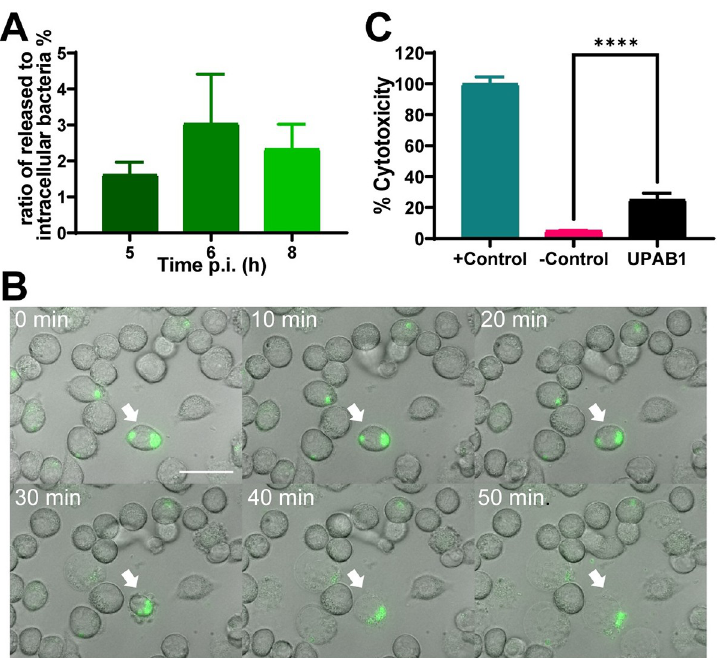
Fig 5. UPAB1 escapes the macrophages by a lytic process. J774A.1 macrophages were infected with UPAB1. (A) At different time points, antibiotic containing medium was replaced by antibiotic-free medium. CFU in supernatants were determined and the ratio of released to intracellular bacteria was calculated. Data represent mean and standard deviation values for 3 independent experiments. (B) Images from time-lapse microscopy showing UPAB1 egress from the invaded macrophages. J774A.1 cells were infected with UPAB1 GFP (green fluorescence). At 7 h p.i. images were taken every 10 min and analyzed with ImageJ software. The white arrow indicates the infected cell. Bars: 20 μ m. (C) LDH activity in the supernatant of infected macrophages was measured at 24 h p.i. Percentage of cytotoxicity was calculated as the activity of released LDH relative to total LDH activity. The mean ± S.D. for two independent experiments is shown. ���� p <